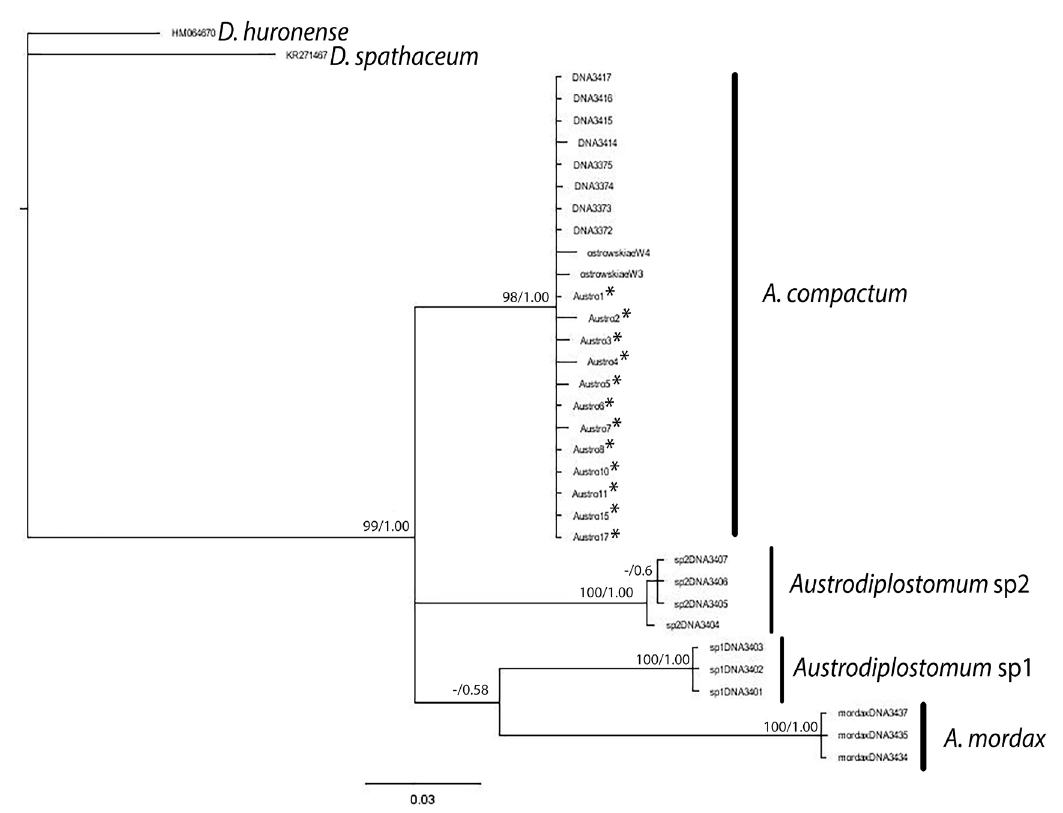
Figure 2 – Bayesian inference (BI) tree inferred with partial sequences of COI mtDNA. The tree was reconstructed using 12 news A. compactum sequences, marked by asterisk (present study). In the analysis are observed 4 main subclades for Austrodiplostomum . Bootstrap support and posterior probability values are given next to each branch. The bar indicates the expected number of substitutions per